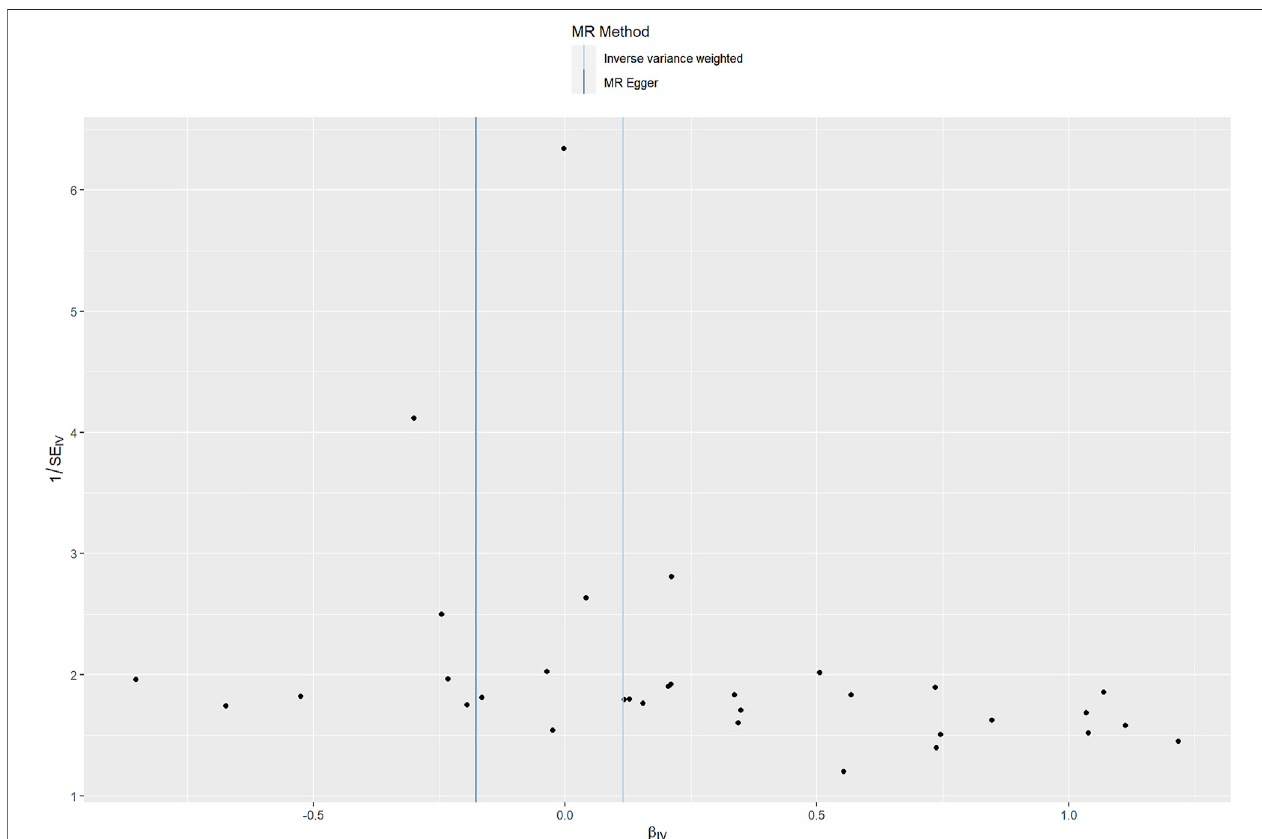
FIGURE 4 | Funnel plot assessing heterogeneity. Blue line represents the inverse-variance weighted estimate, and dark blue line represents the MR-Egger estimate. SE, standard error; IV, instrumental variable.